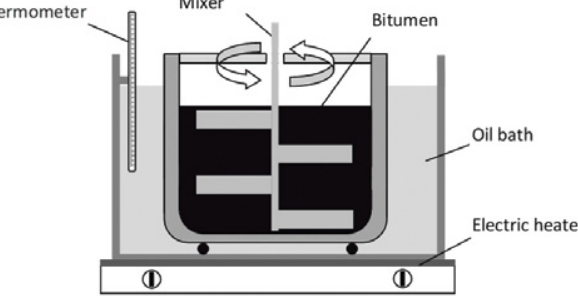
Figure 5. Diagram of the oil bath equipment for modifying the